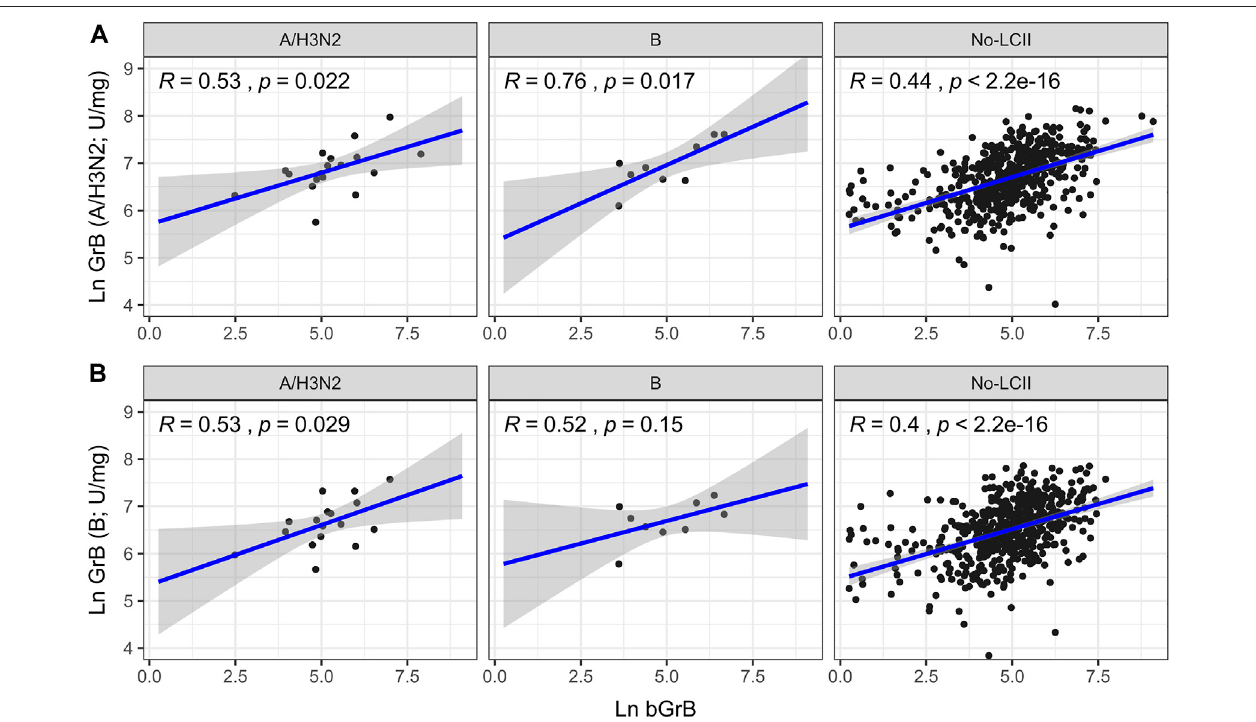
FIGURE1| Correlationofnatural-log(Ln)basalgranzymeBactivity(bGrB)withtotalGrBinresponseto (A) H3N2and (B) Bviruspriortovaccination.Trendlineand con fi dence interval (shaded area) and individual data points shown for participants who developed A/H3N2 (n (cid:1) 18) and B (n (cid:1) 9) LCII and those who didn ’ t (ie. Null; n (cid:1) 582), along with Pearson ’ s correlation (R) and test signi fi cance